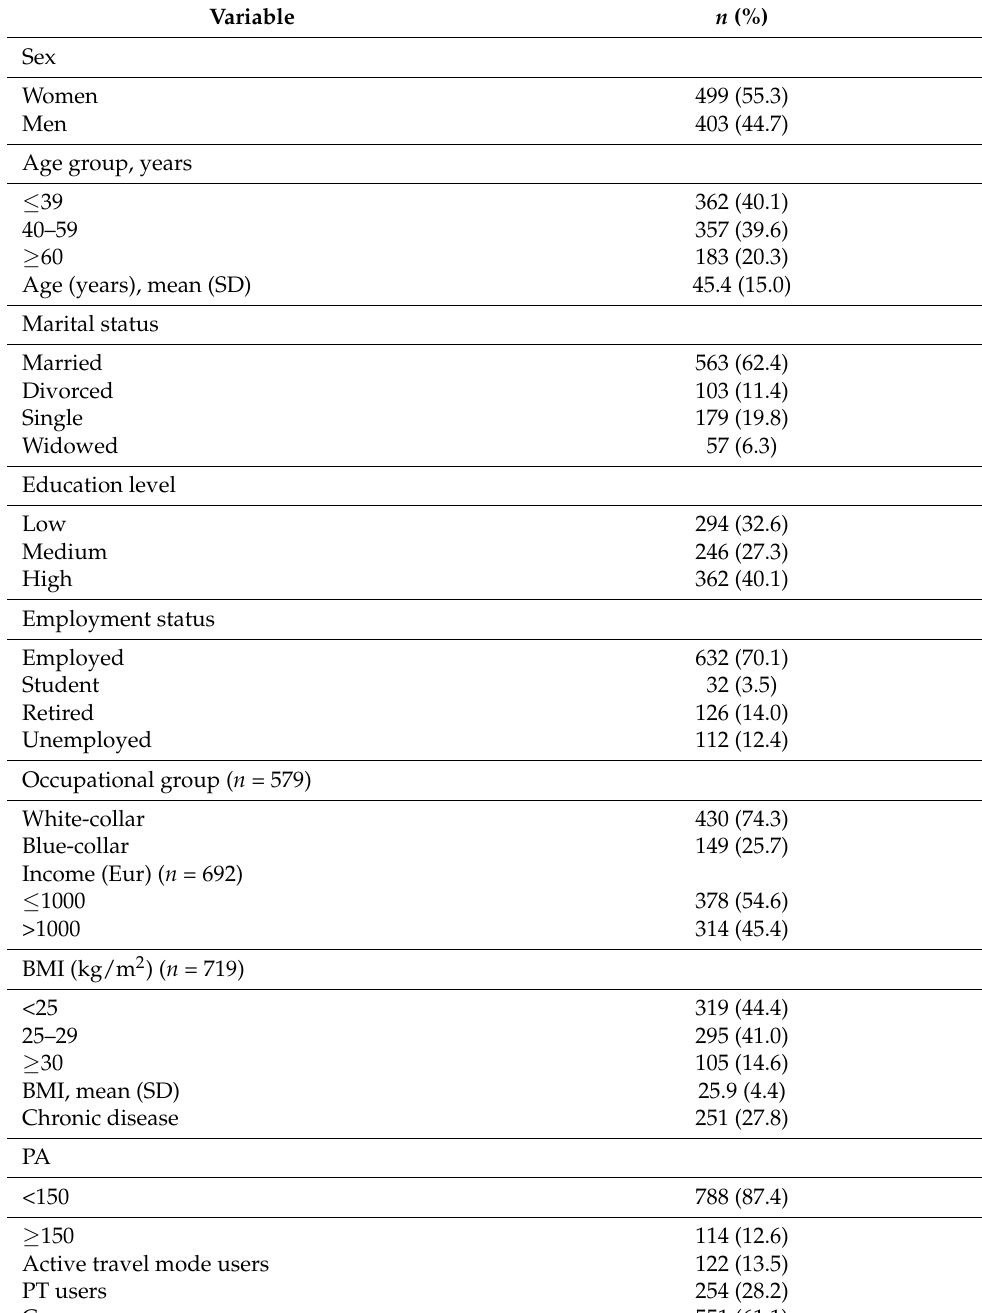
Table 1. Characteristics of the study population ( n =